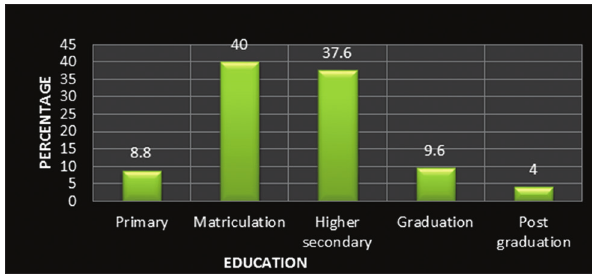
Figure-2: Distribution of respondents according to